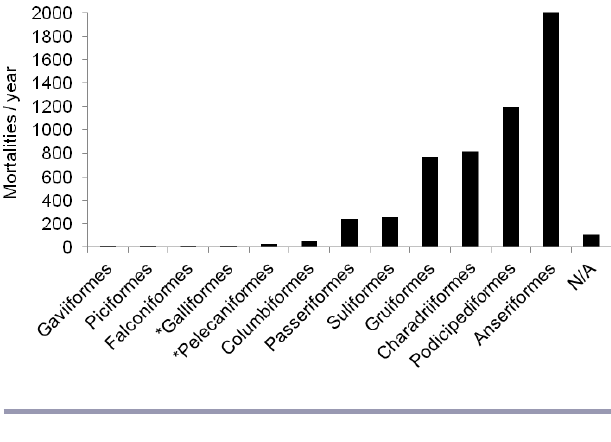
Fig. 3 . Frequency distribution of the number of bird carcasses found per kilometer of transmission line per